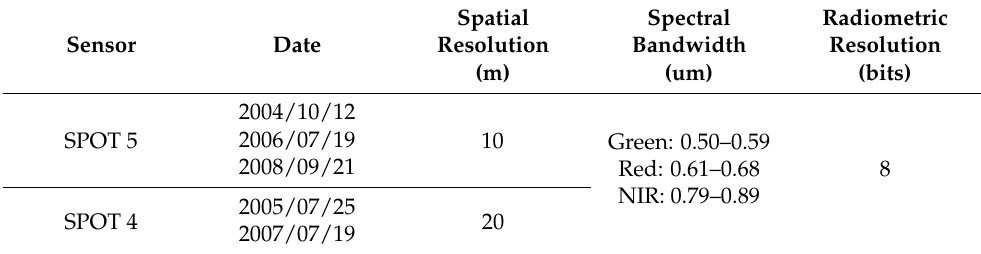
Table 3. SPOT satellite images that were used in this